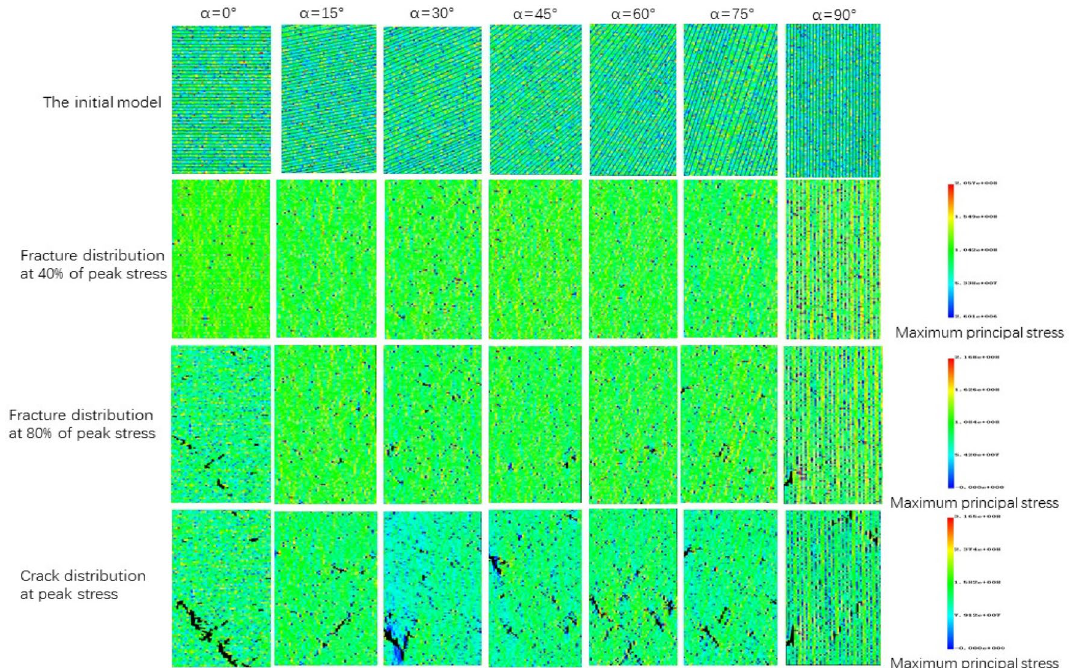
Figure 23. Schematic diagram of progressive destruction of Phyllite under different joint inclinations.